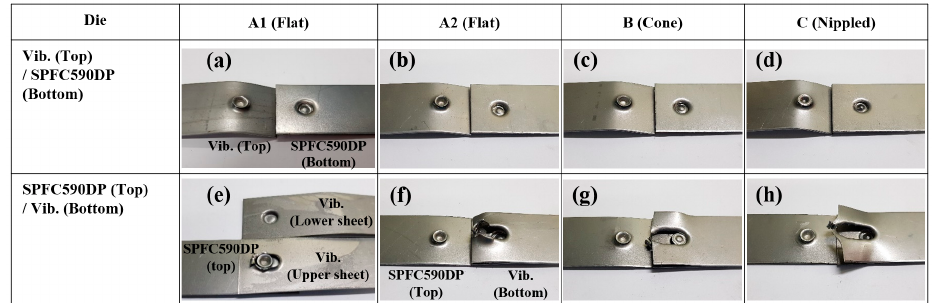
Figure 7. The failure modes of self-piercing riveted joints formed between vibration-damping steel and SPFC590DP with respect to the die types and the panel con fi gurations. ( a , e ) die type A1, ( b , f ) die type A2, ( c , g ) die type B, ( d , h ) die type C.